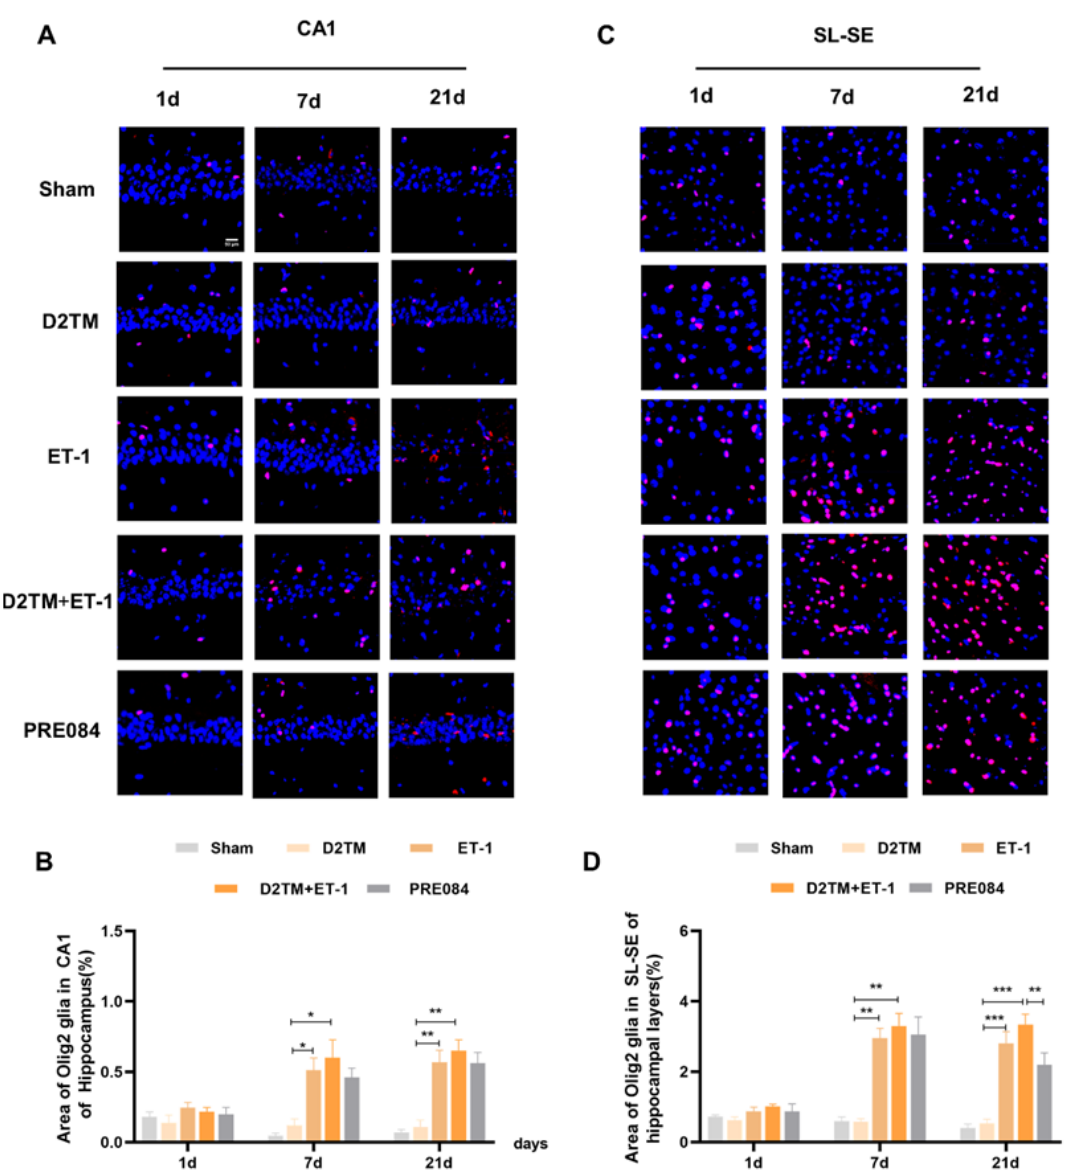
Figure 6. Sigma-1 receptor activation promoted oligodendrogenesis differentiation in diabetic mice with stroke. ( A) and ( C ) Olig2 immunostaining (red) with DAPI (blue) was performed to detect oligodendrogenesis in the CA1 and the substratum lacunosum (SL) and substratum eumoleculare (SE) hippocampal layers at 1, 7, and 21 d after ET-1 injection. ( B ) and ( D ) Quantification of the area of the Olig2-immunostained cells in the CA1 and SL – SE of the hippocampus. Data are expressed as mean ± SEM; n = 4 –5/group. Scale bars = 25 μm. * p < 0.05, ** p < 0.01, *** p < 0.001.